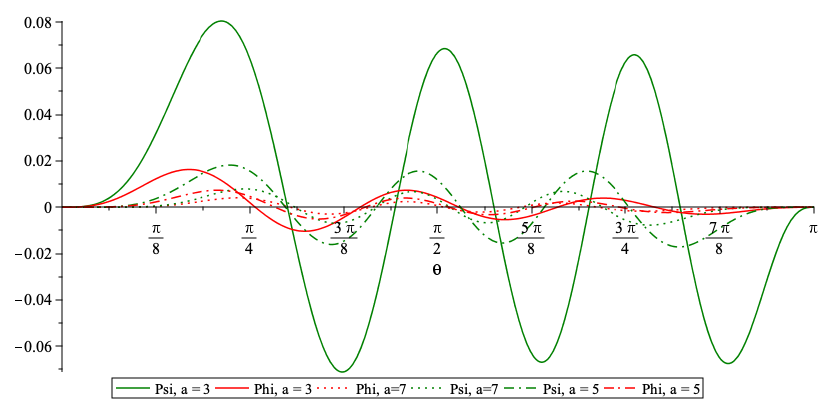
Figure 2. Ψ n ( θ ; a , b ) in green and Φ n ( θ ; a , b ) in red with n = 5, b = 3 and a =